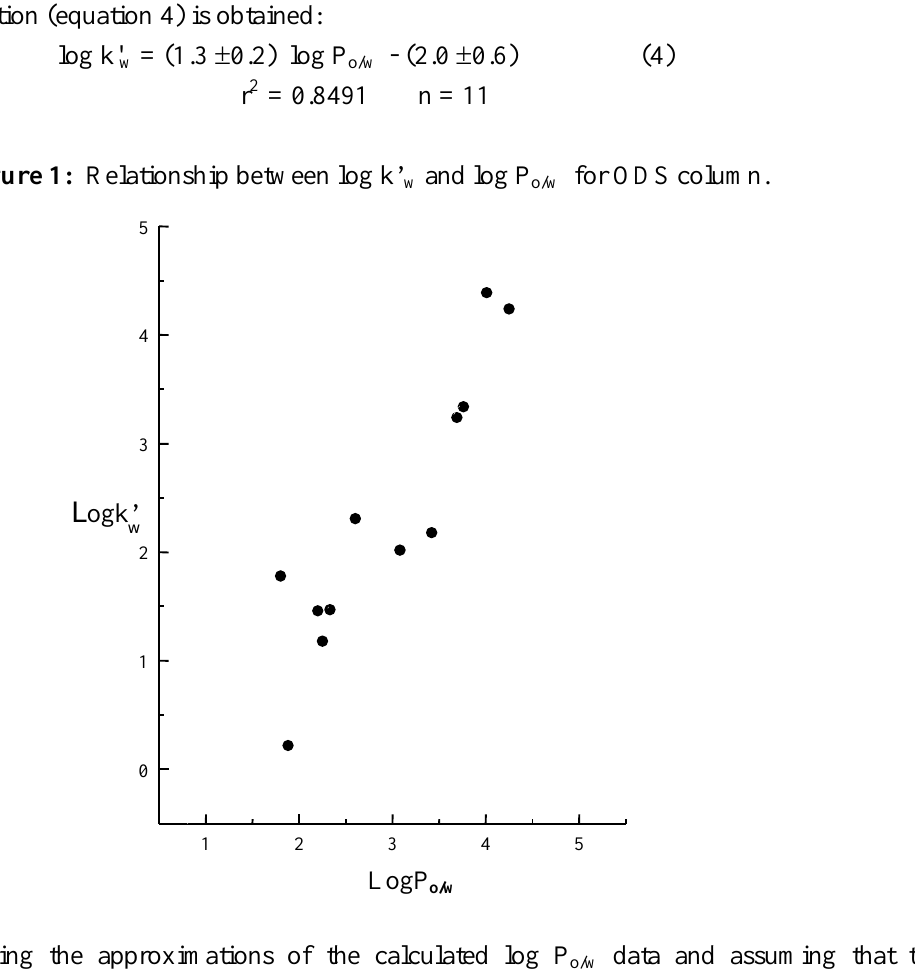
Figure 1: Relationship between log k’